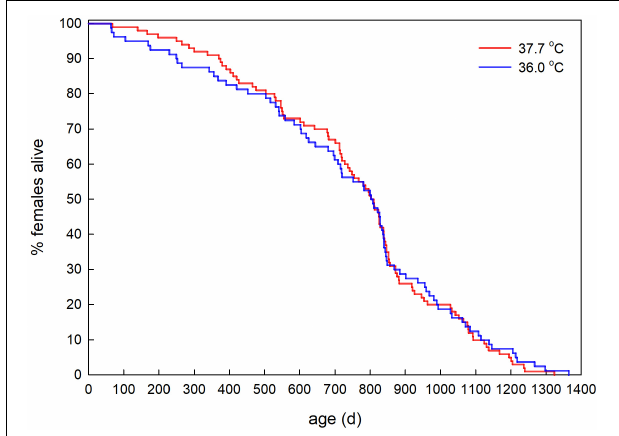
FIGURE 5 | Age-specific survival of adult female Japanese quail incubated at 37.7 ◦ C ( n = 100) or 36.0 ◦ C ( n =